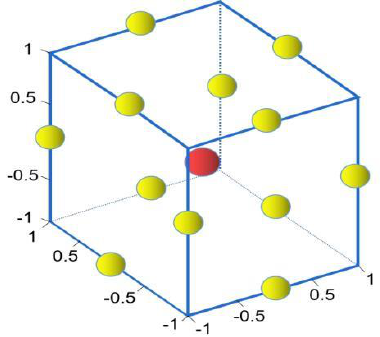
Figure 13. Schematic diagram of three-factor and three-level experiments.